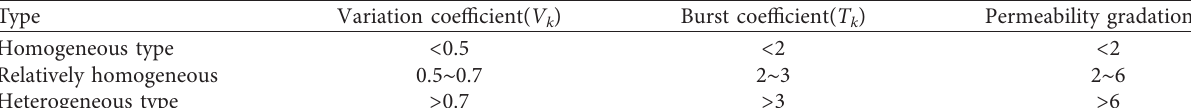
Table 2: Division standard of reservoir